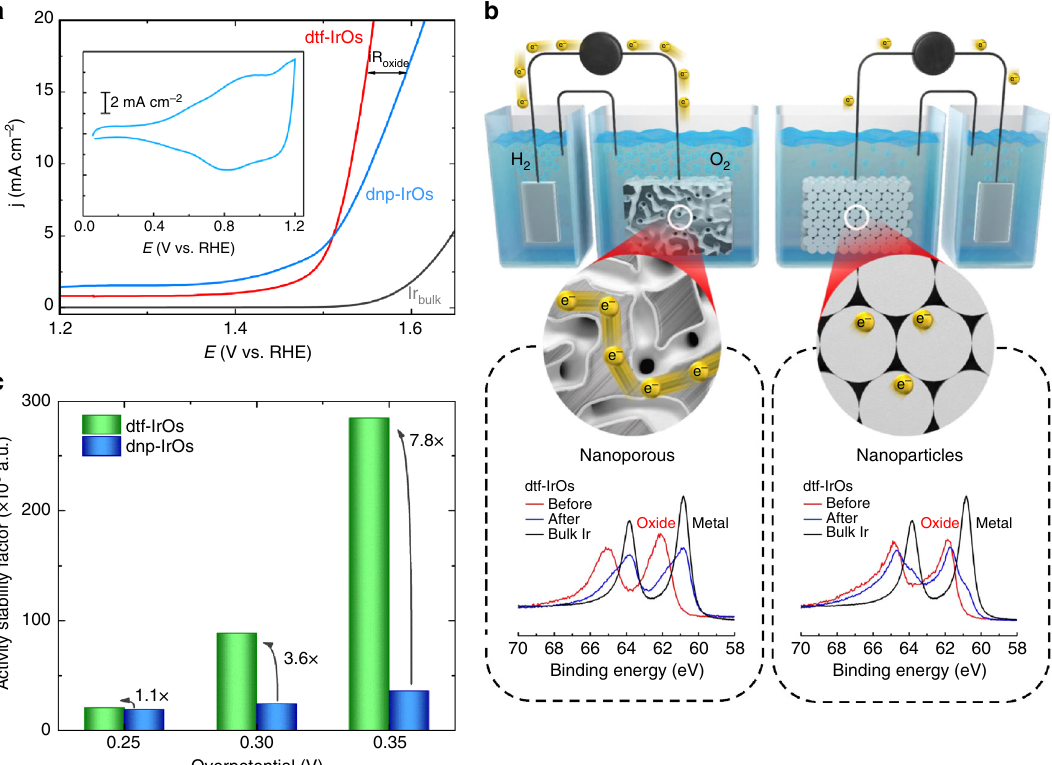
Fig. 3 Activity-conductivity relationships in dealloyed thin- fi lm and nanoparticles. a Comparison between OER polarization curves for Ir-poly, dtf-Ir 25 -Os 75 and dnp-Ir 50 Os 50 , indicating that conductivity limitations are observed for dnp-Ir 50 Os 50 at higher current densities (denoted as iR oxide ). Inset shows the corresponding CV with a similar OH ad pro fi le as in Fig. 1c. b XPS sputter etching experiments demonstrating that the dtf-Ir 25 Os 75 consists of an IrO x shell with Ir-metallic core, in contrast to dnp-Ir 50 Os 50 that consists entirely of IrO x . Schematic illustrates the impact of multiple oxide-oxide interfaces (present on dnp-Ir 50 Os 50 electrodes) on conductivity. c Change in Activity-Stability Factor (ASF) values with overpotential for dtf-Ir 25 Os 75 and dnp-Ir 50 Os